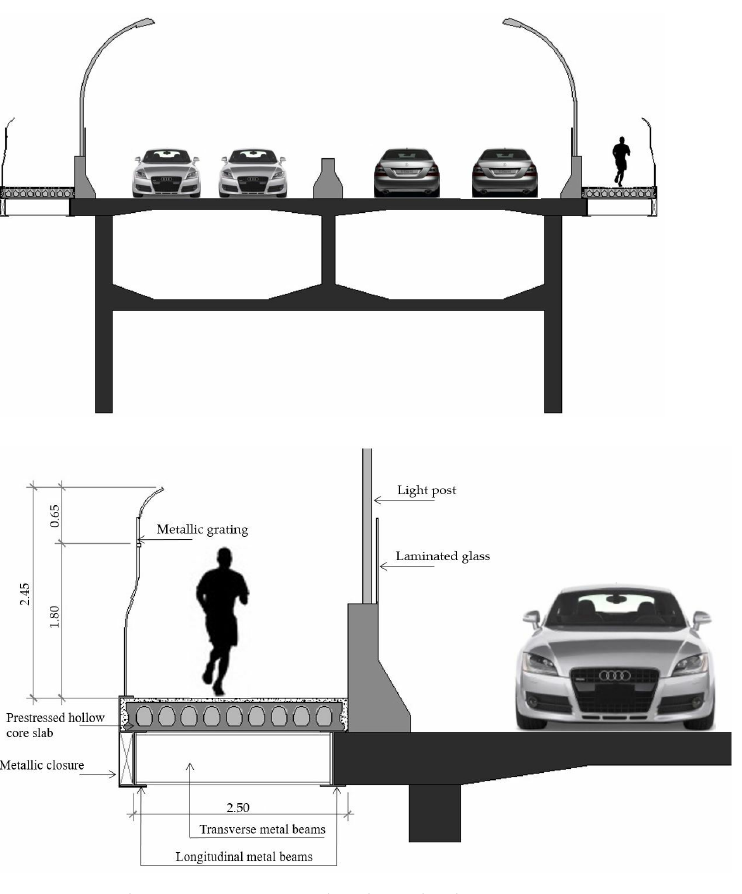
Figure 3. Bridge cross-section and technical solution.